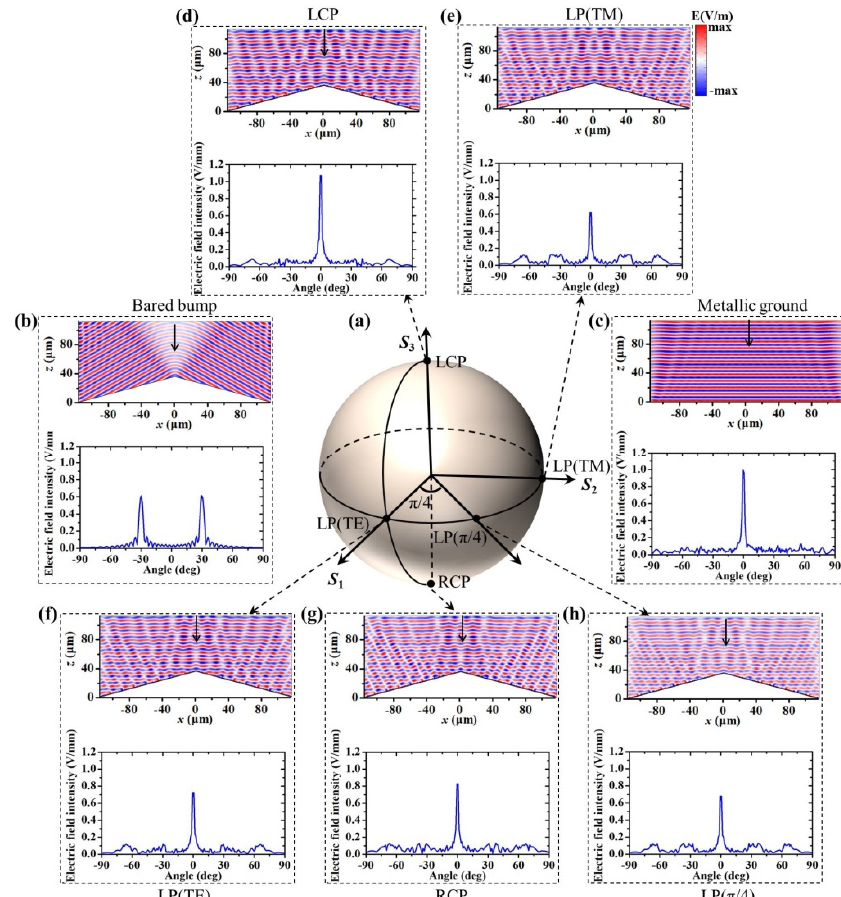
Figure 2. A Poincaré sphere representation of cloaking response under arbitrary SOP for normal incidence. ( a ) A Poincaré sphere and five points that characterize different SOP. The calculated reflected spatial E-field patterns in the x – z plane (up panels) and the corresponding farfield radiation patterns (bottom panels) for the bared bump under LCP incidence ( b ), metallic ground under LCP incidence ( c ) and the cloaked bump under LCP ( d ), LP (TM) ( e ), LP (TE) ( f ), RCP ( g ) and ( h ) LP ( π /4) input light, respectively.